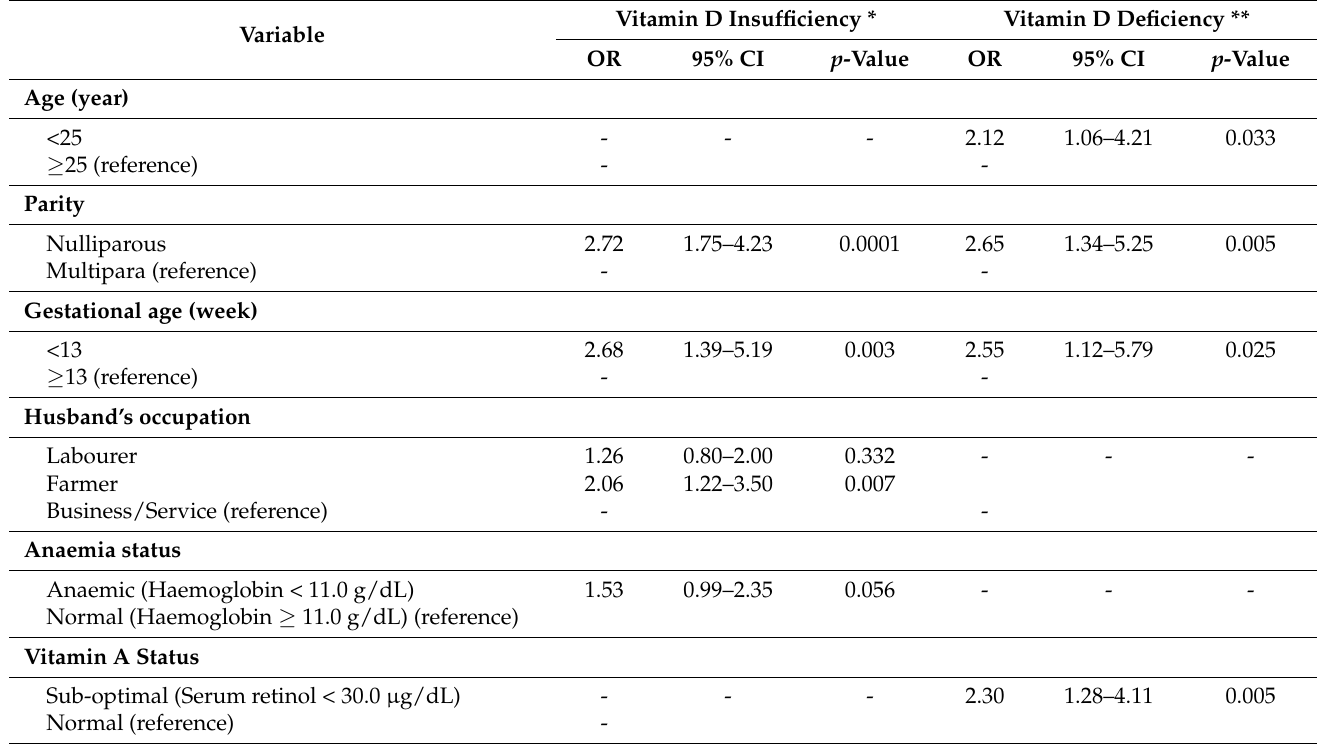
Table 5. Logistic regression analysis (odds ratios) for vitamin D deficiency and insufficiency among pregnant rural women in